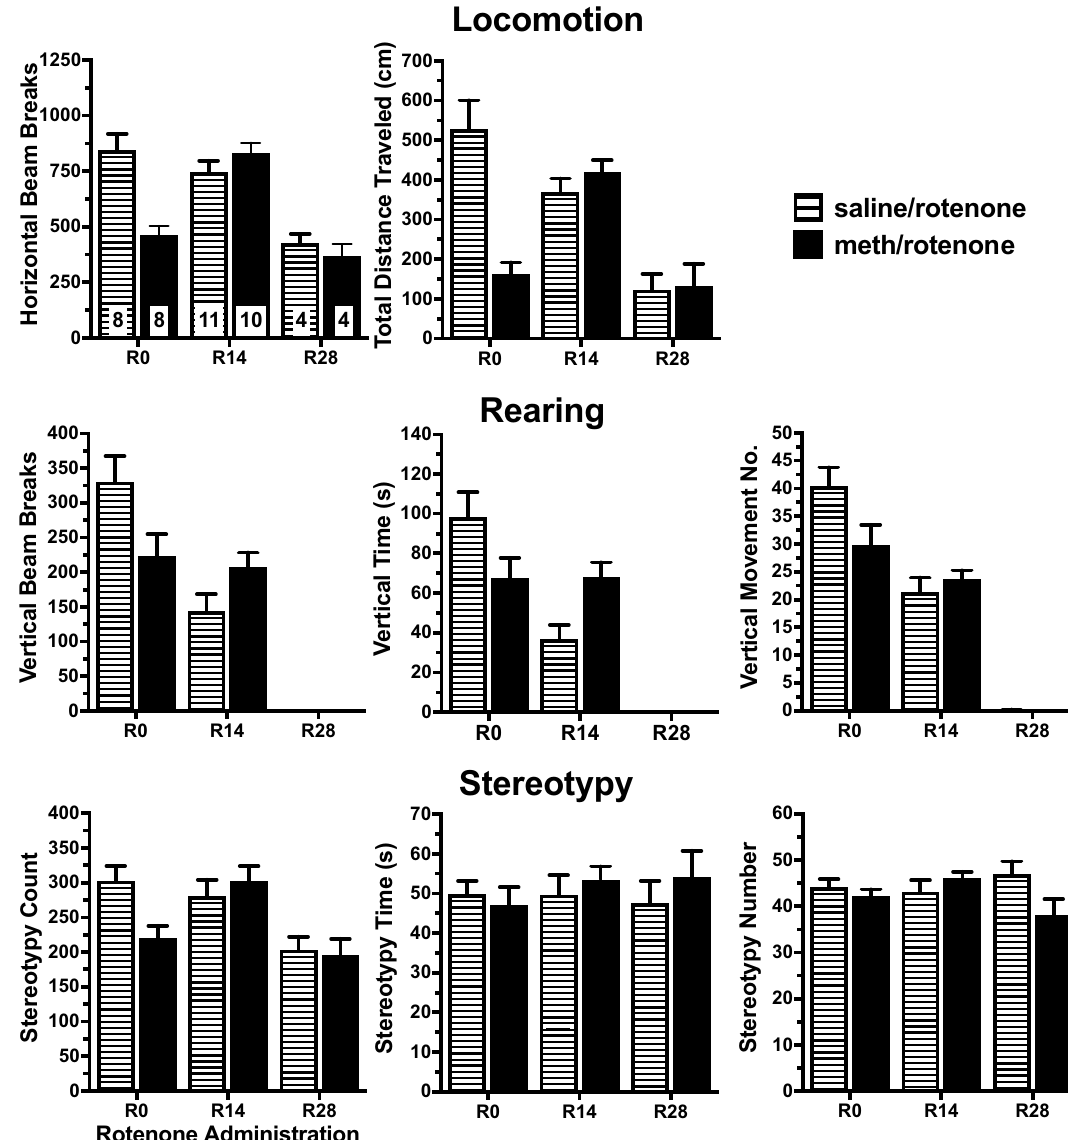
Figure 8. Peak phase motor effects of rotenone administration time on the expression of behavioral sensitization after a methamphetamine (meth) acute challenge. R28 administration of rotenone reduced horizontal bean breaks, total distance traveled, vertical beam breaks, vertical movement number, and vertical time for R28 saline/rotenone rats compared to R0 and R14 saline/rotenone rats. R14 administration reduced in total distance traveled, vertical beam breaks, vertical time, and vertical movement number in R14 saline/ rotenone rats compared to R0 saline/rotenone rats. R0 meth/rotenone rats had reduced horizontal beam breaks, total distance traveled, vertical beam breaks, vertical time, and vertical movement number compared to R0 saline/rotenone rats. R14 meth/rotenone rats had increased vertical time compared to R14 saline/rotenone rats. R14 meth/rotenone rats had increased horizontal beam breaks and total distance traveled compared to R0 meth/ rotenone rats. R28 meth/rotenone rats had reduced horizontal beam breaks, total distance traveled, vertical beam breaks, vertical time, and vertical movement number compared to R0 and R14 meth/rotenone rats. The first bar graph contains the samples size for each treatment